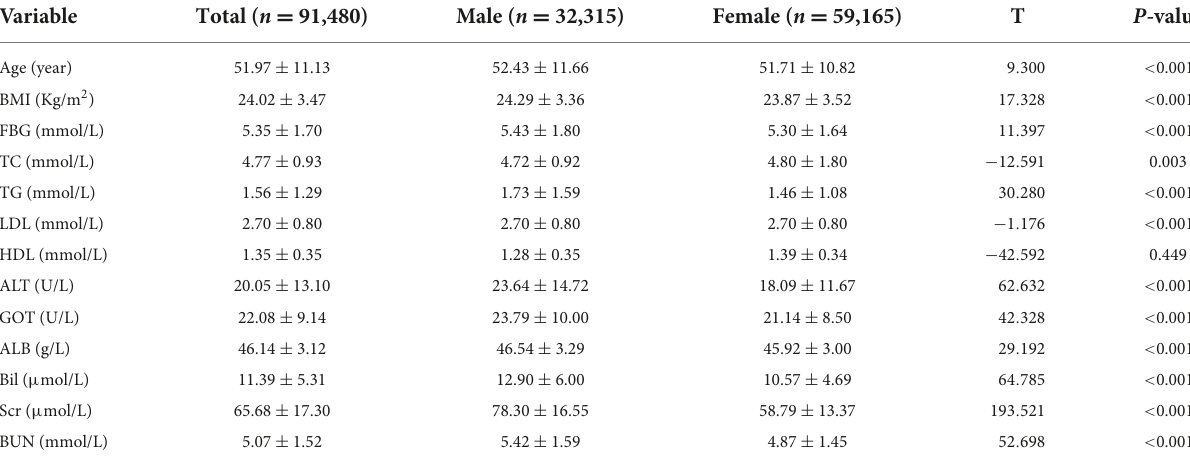
TABLE 1 Descriptive characteristics of participants by gender.